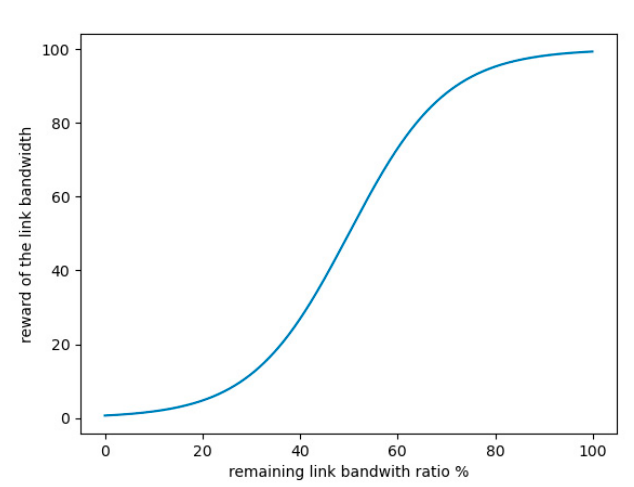
Figure 6. Reward function curve based on link bandwidth remaining.